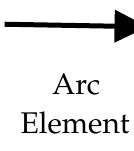
Figure 1. Basic elements of the Production Flow Schema (PFS). The PFS represents the system conceptual description. Arcs connect activity and distributor elements. Activity elements can be refined into a new PFS model or a